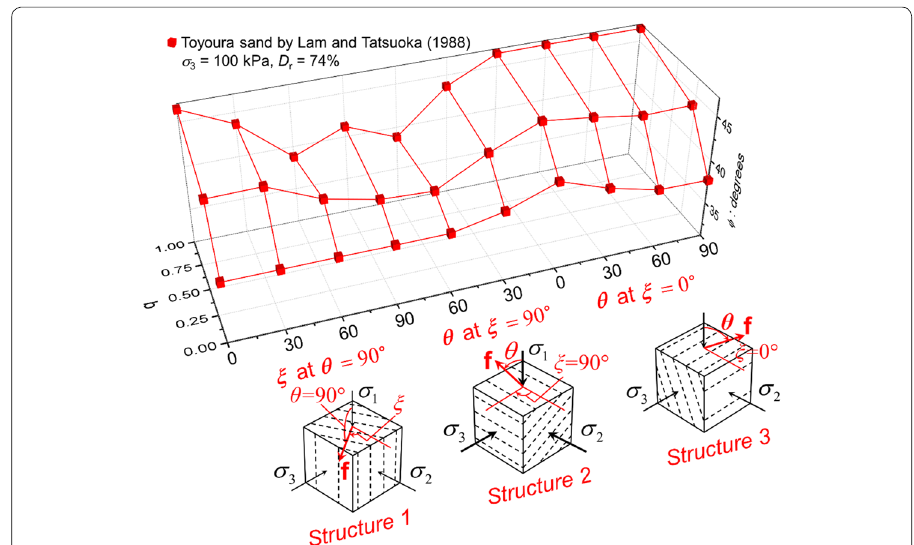
Fig. 6 Anisotropic strength of Toyour sand in plane strain compression tests in three fabric